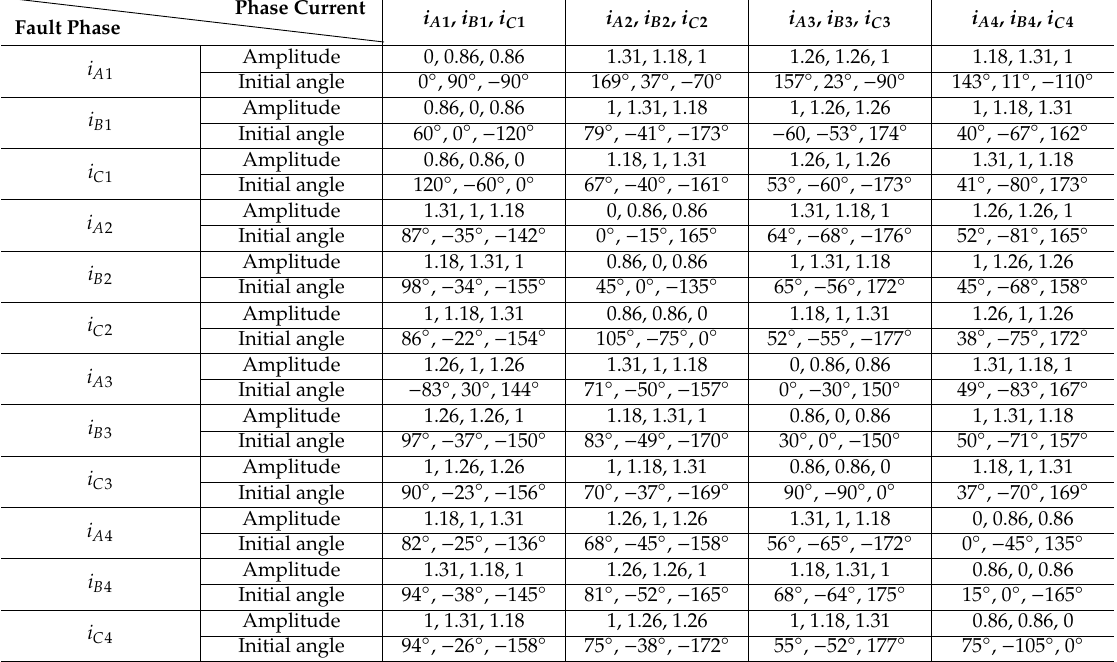
Table 1. Minimum copper consumption (MCC) fault-tolerant control